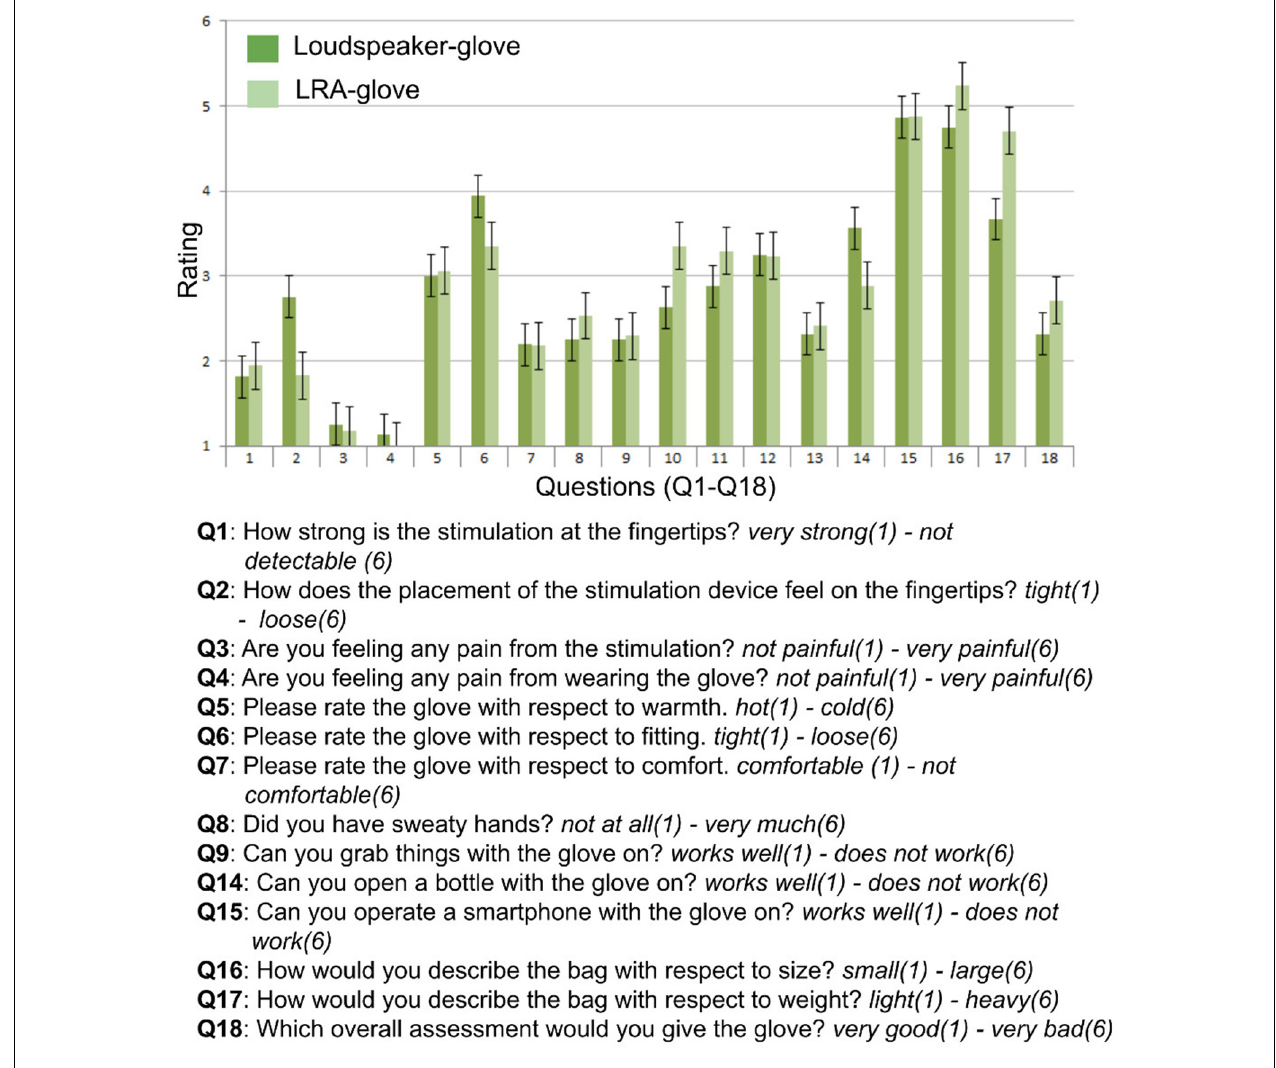
FIGURE 3 | Questionnaire items and results. Rating scales ranged between 1 and 6, questions (Q) and answer dimensions (written in italics ) are